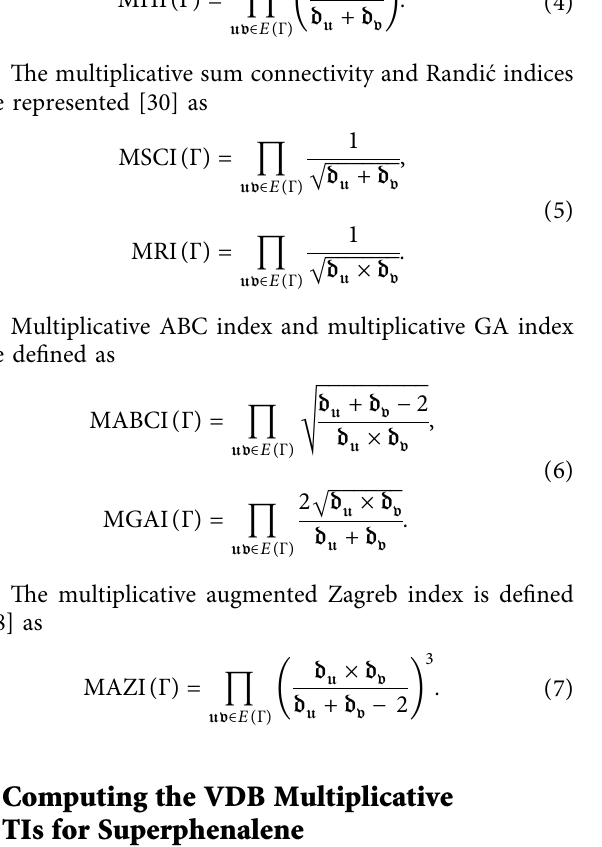
Table 1: Edge partition table for superphenalene